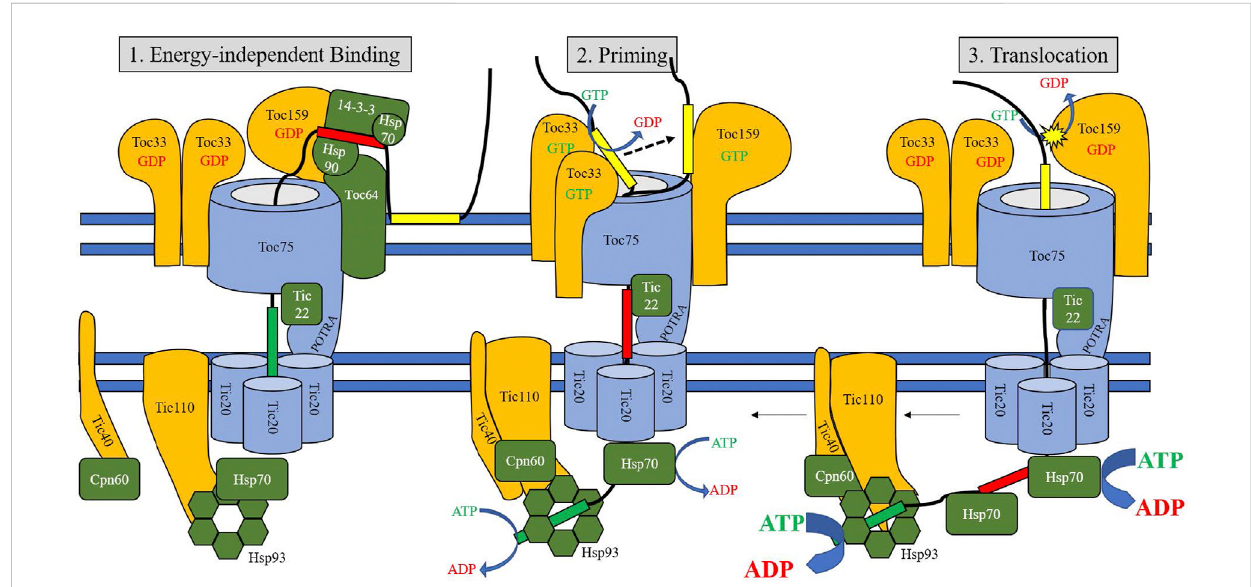
FIGURE 2 Model of TOC/TIC translocation. The three stages of translocation are represented in three panels (A – C), corresponding to Energy-Independent Binding, Priming, and Translocation stages. Initial stages (1) involve binding of the central transit peptide domain to cytosolic chaperones, and binding of the proximal domain to TIC22 and the TO75 POTRA domains. Transition to the early translocation intermediate stage (2) involves translocation of the proximal domain across the inner membrane and binding to stromal chaperones, while the distal domain is stabilized by TOC GTPases. Triggering the fi nalstageof translocation (3)involves a fi nalGTPasecyclefor primed transit peptides, followedby strongATPaseactivity ofstromal Hsp70 and other chaperones topullthepreproteinintothestroma. TheN-terminal motifsofthetransitpeptidearerepresentedingreen,thecentralmotifsinred,andthe C-terminal motifs in yellow. Proteins shown in blue represent pore or channel proteins, proteins shown in orange are receptor or scaffold proteins, and proteins shown in green are chaperones.